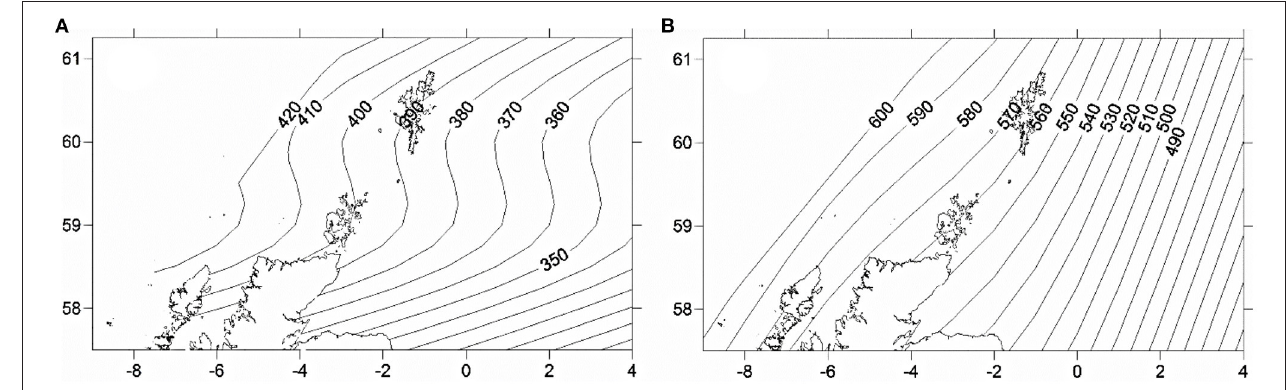
FIGURE 2 | Predicted spatial variation in length at age 2 (A) and 3 (B) across the study area in 2014. Numbers refer to length (mm) at age isolines showing decrease from west to east.